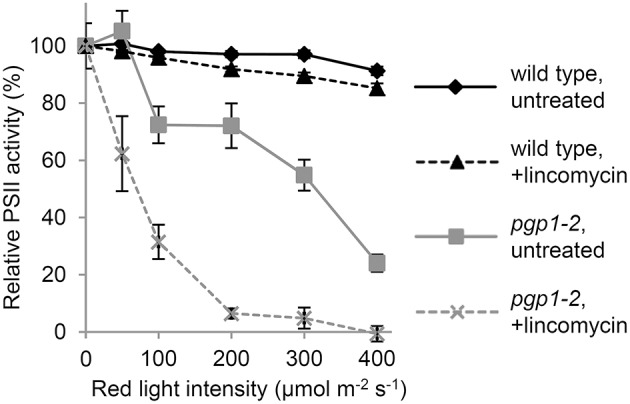
Photoinhibition of Photosystem II (PSII) activity under red-light irradiation. Maximum quantum yield of PSII (Fv/Fm) was determined as a measure of PSII activity after red light irradiation for 1 h. Before red light irradiation, leaves were treated with or without lincomycin for 3 h. Data are mean ± SE from 8 independent experiments.